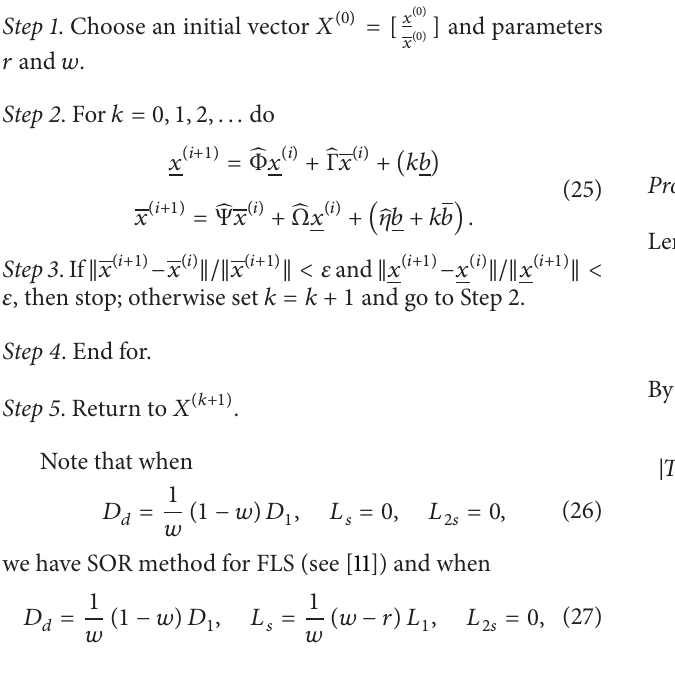
Algorithm 10. Mixed type splitting iterative methods 1 for